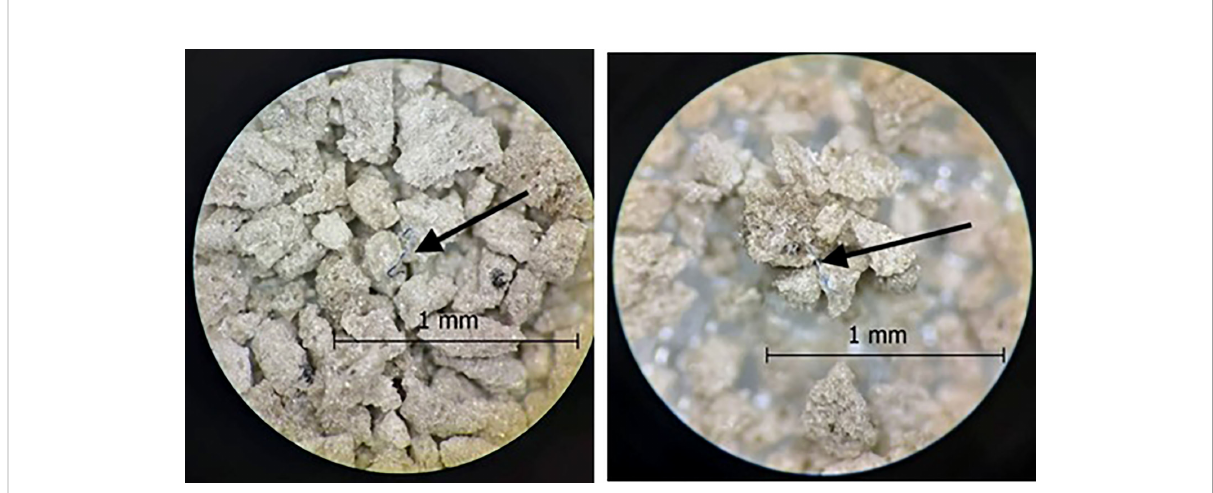
FIGURE 4 Examples of MPs attached to pumice stone (left, right). Note the light blue fi ber in the middle of the